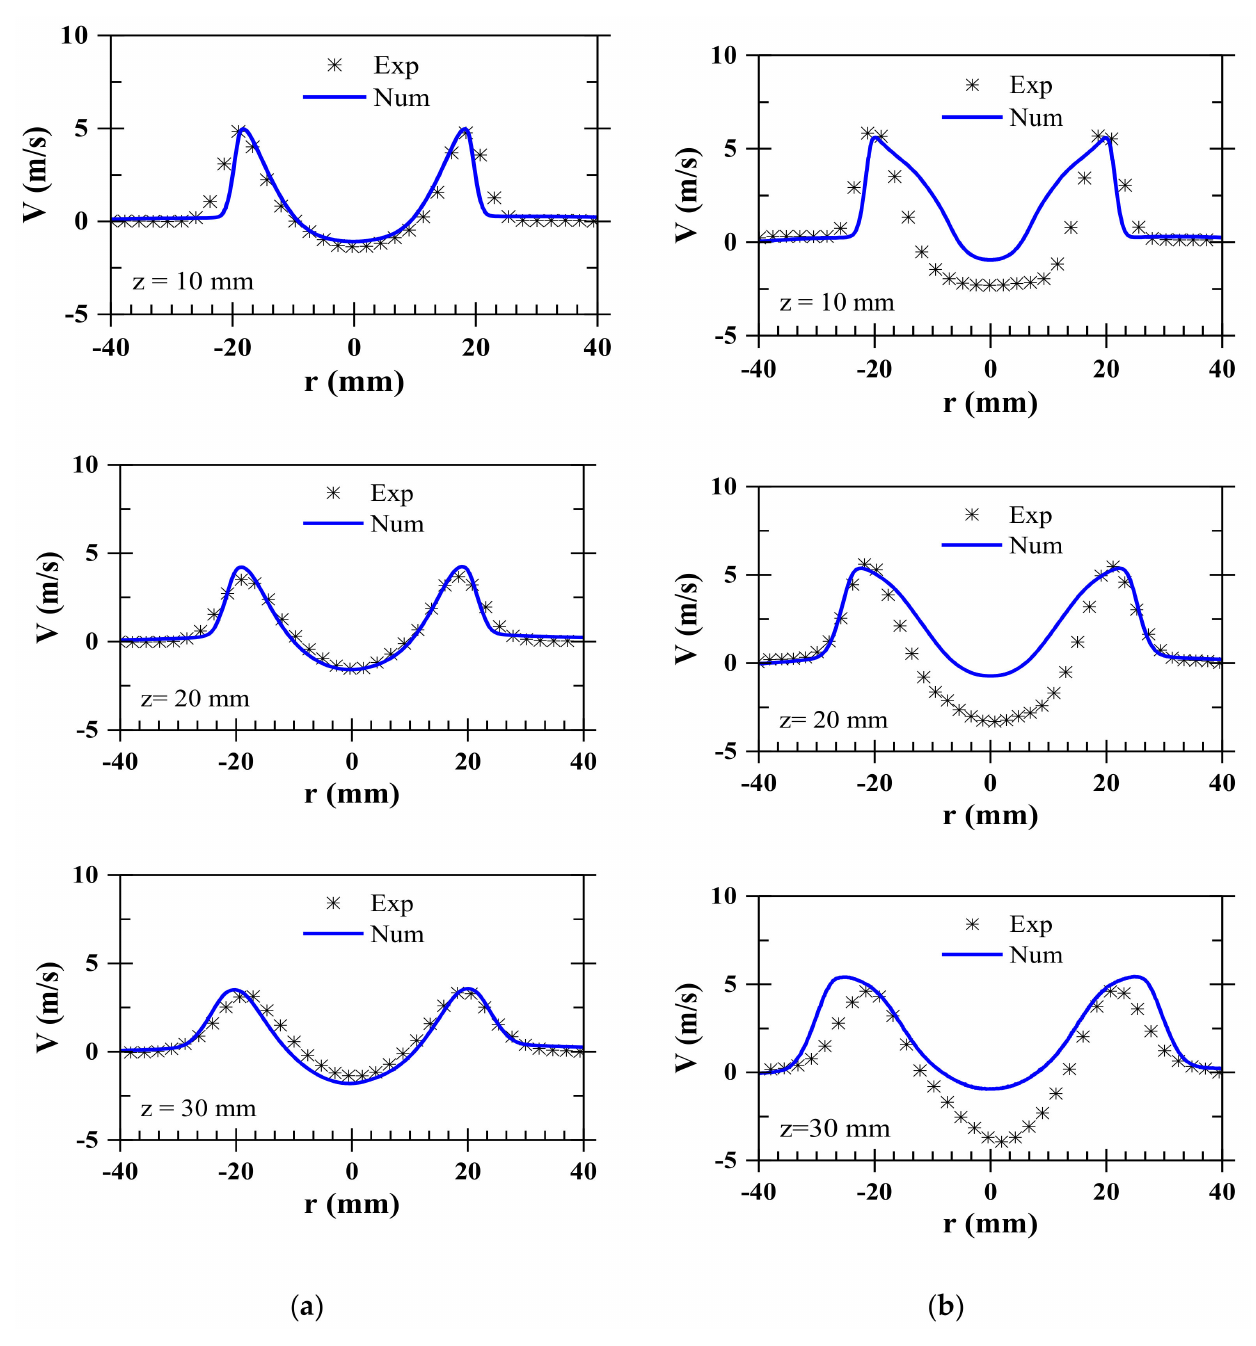
Figure 3. Obtained numerical profiles of radial mean axial velocity compared to experimental data for non-reacting and reacting cases; ( a ) non − reacting case; ( b ) reacting